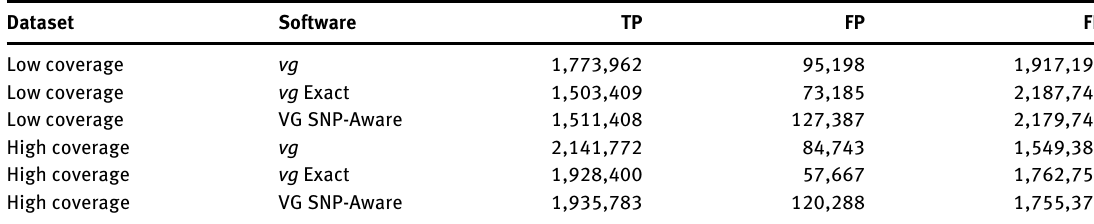
Table 4: Genotyping results for all tools and datsets: true positive, false positive and false negative.